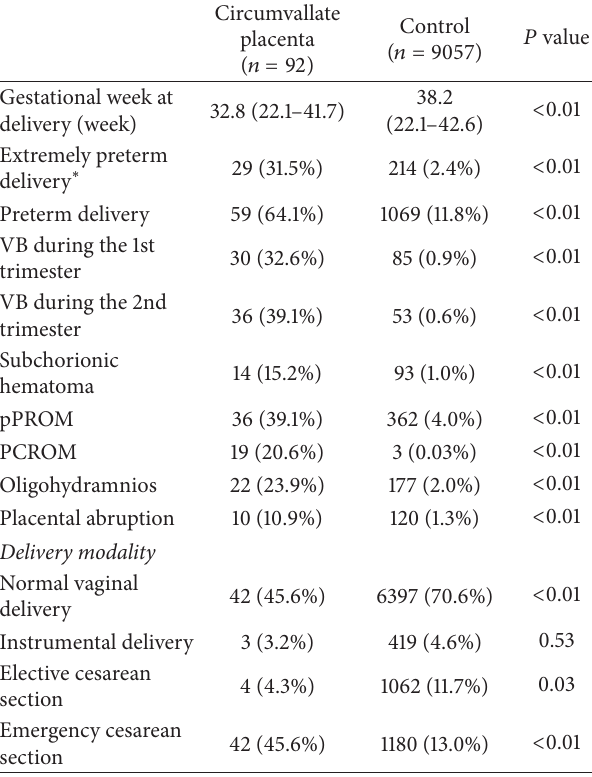
Table 2: Comparison of pregnancy outcomes between circumval- late placenta and control groups.